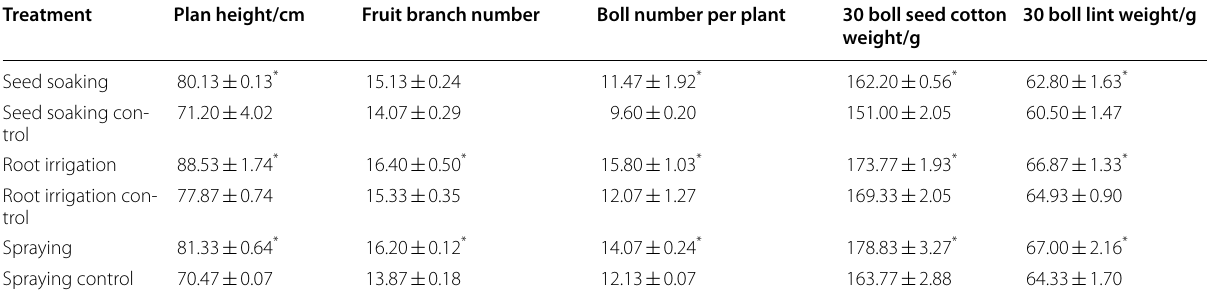
Data are mean SD; * indicates that there is a significant difference between the treatment and the control ( P < 0.05 ) ± Table 6 Effects of different treatments of EBS03 on cotton yield Treatment